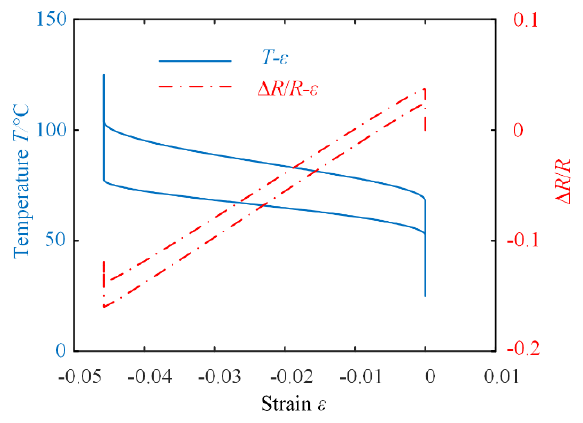
Figure 7. The relationship between T - ε and σ -Δ R / R at 117 MPa.